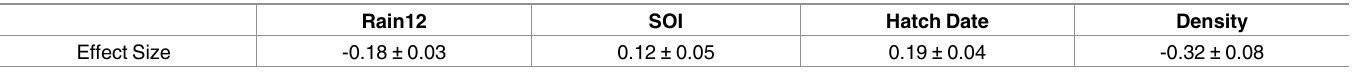
Table 1. Parameterestimatesfor the best-fit model of nestling survival with standard error.